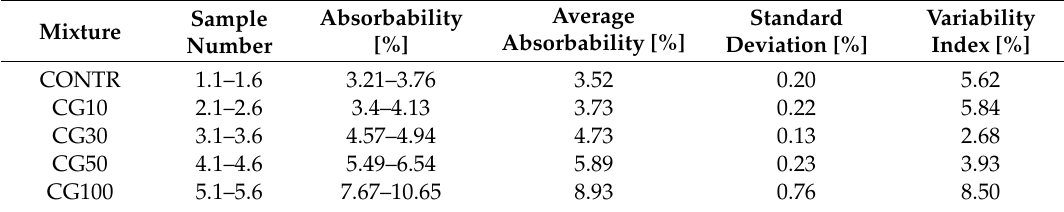
Table 10. Absorption test results.